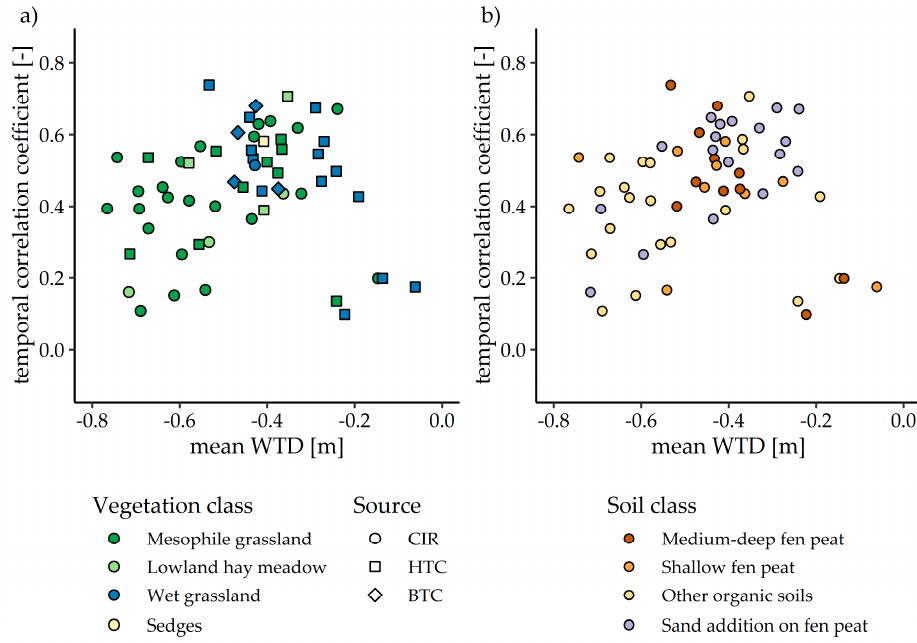
Figure 7. Temporal Spearman correlation coefficients between WTD and backscatter ( σ 0 ϴ (VV) constant, all orbits) in dependence of site-specific mean WTD including ( a ) vegetation class (different colours) and source information (different symbols), and ( b ) soil class. The correlation coefficients were calculated after excluding times with WTD > − 0.05 m. The source of the vegetation class is either a colour-infrared based classification (CIR), habitat classification (HTC) or biotope type classification (BTC).